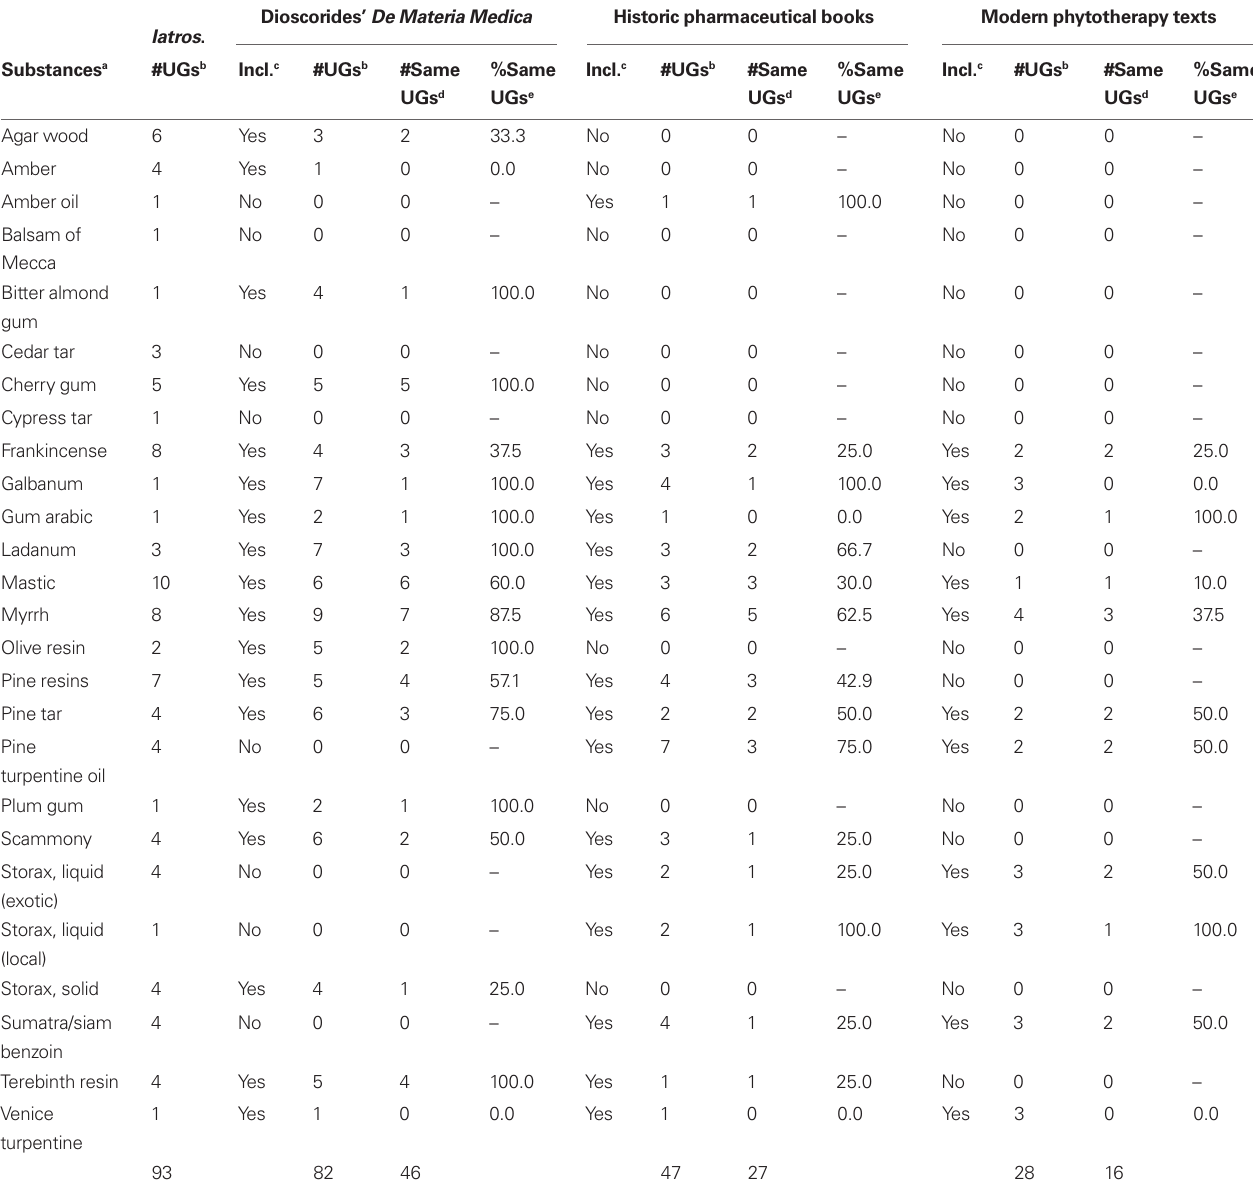
Table 4 | Comparison of the substances and ugs included in the iatrosophia to those of other texts.